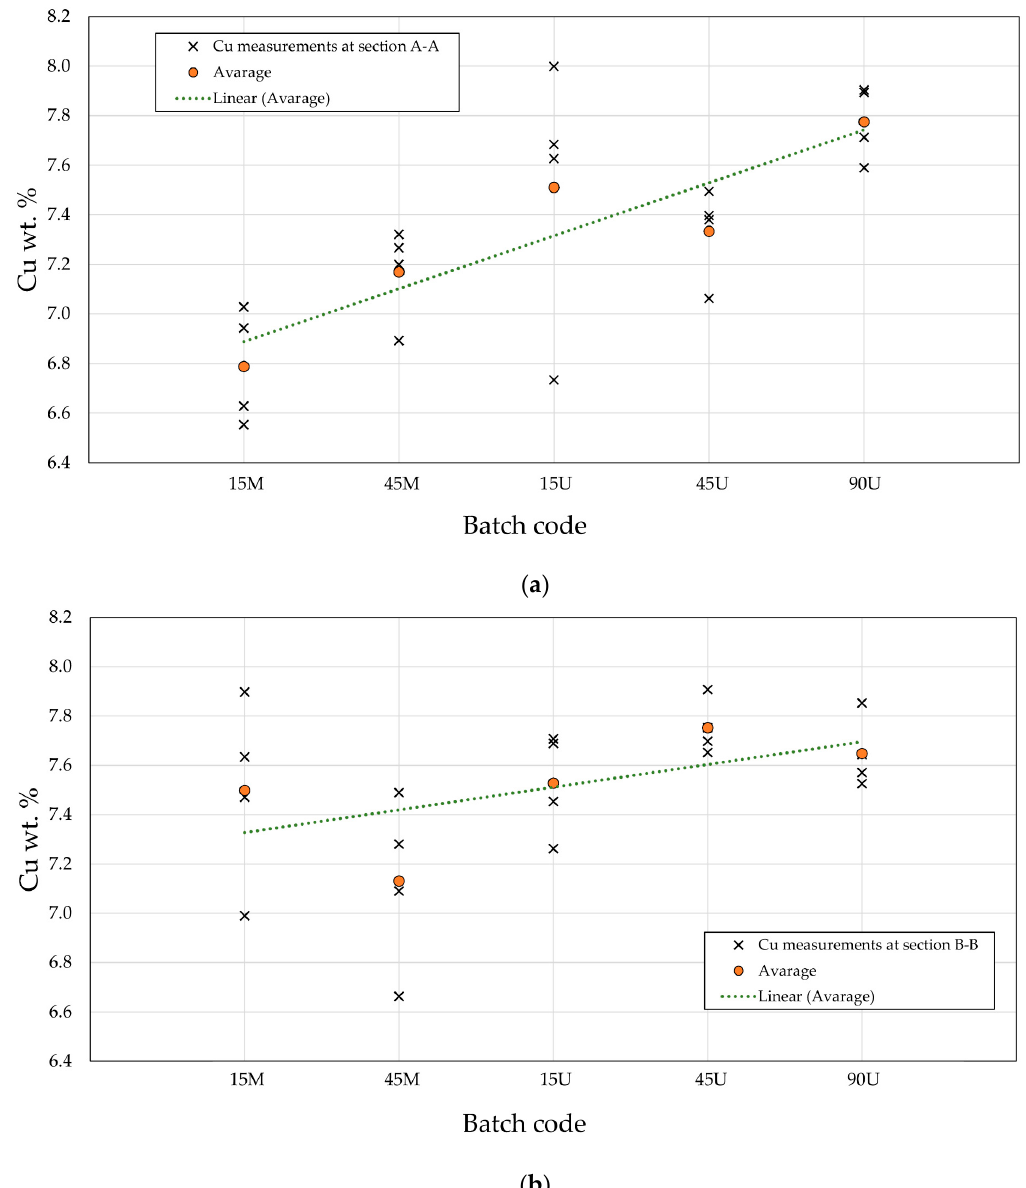
Figure 15. Cu content in the produced alloys ( a ) at section A–A at the middle of the samples and ( b ) at section B–B.